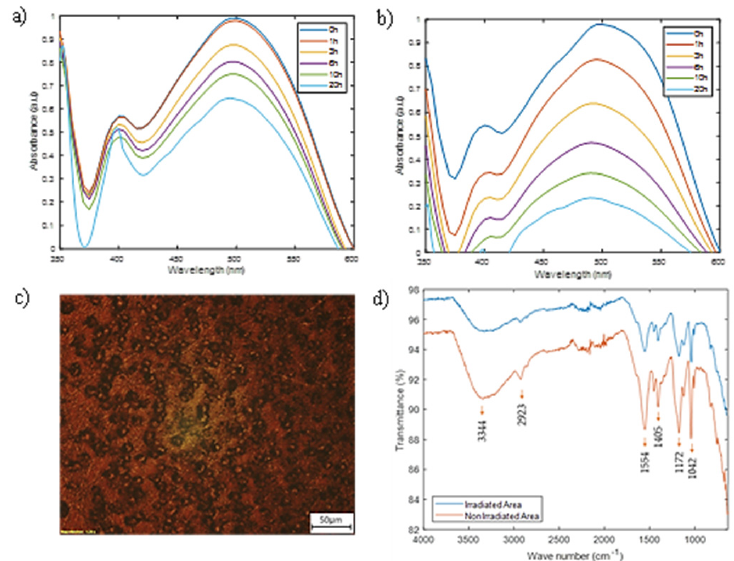
Figure 7. ( a ) Evolution of the degradation rate of CR deposited into S0 sample for a total irradiation time of 20 h; ( b ) evolution of the degradation rate of CR deposited into S1 sample for a total irradiation time of 20 h; ( c ) optical microscopy image of a micrometric degraded area of the dye; ( d ) FTIR spectra of the irradiated and non-irradiated area of the Congo Red sample.